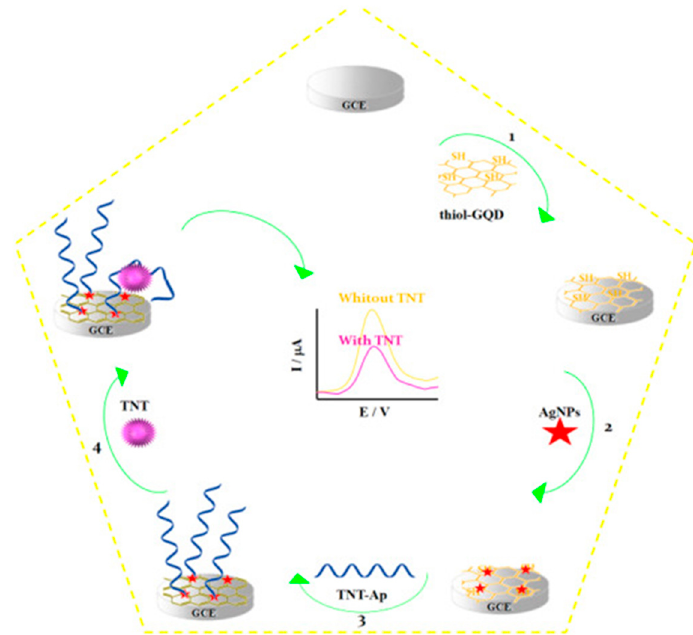
Figure 7. Label-free aptasensor developed for the determination of TNT by immobilizing the NH 2 -Ap onto an AgNPs/thiol-GQD/GCE and performing the DPV detection in the presence of RU. Reprinted with permission from [59]. Copyright Elsevier, 2017.